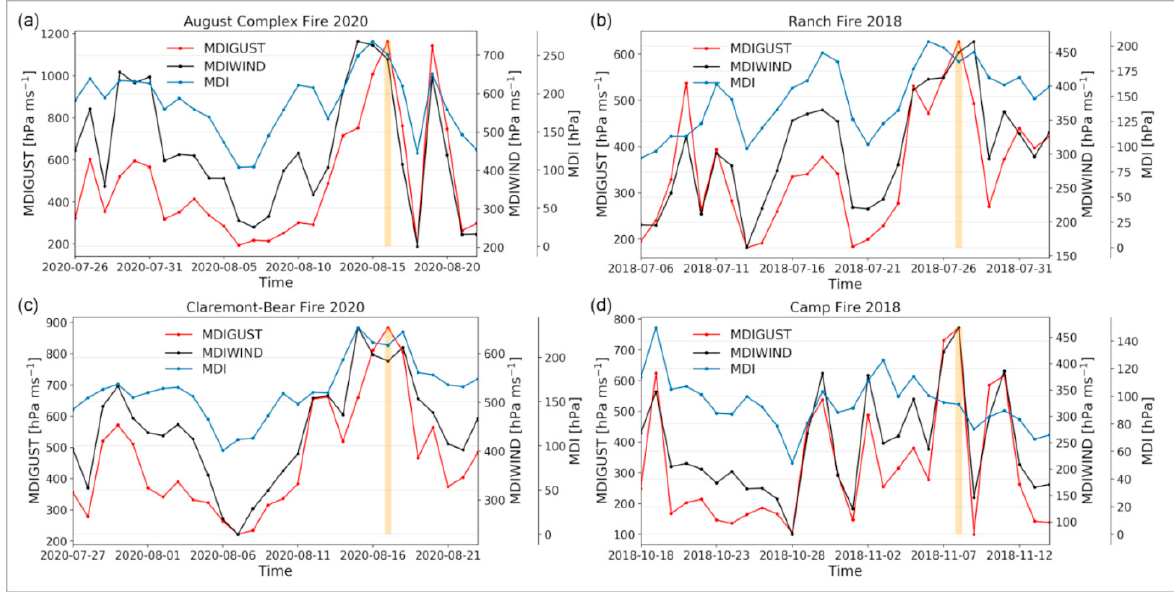
Figure 2. Time series of the daily averaged ignition location indices for each wildfire. ( a ) August Complex Fire 2020, ( b ) Ranch Fire 2018, ( c ) Claremont-Bear Fire 2020, and ( d ) Camp Fire 2018. The ignition date for each wildfire is shown as a thick orange line.